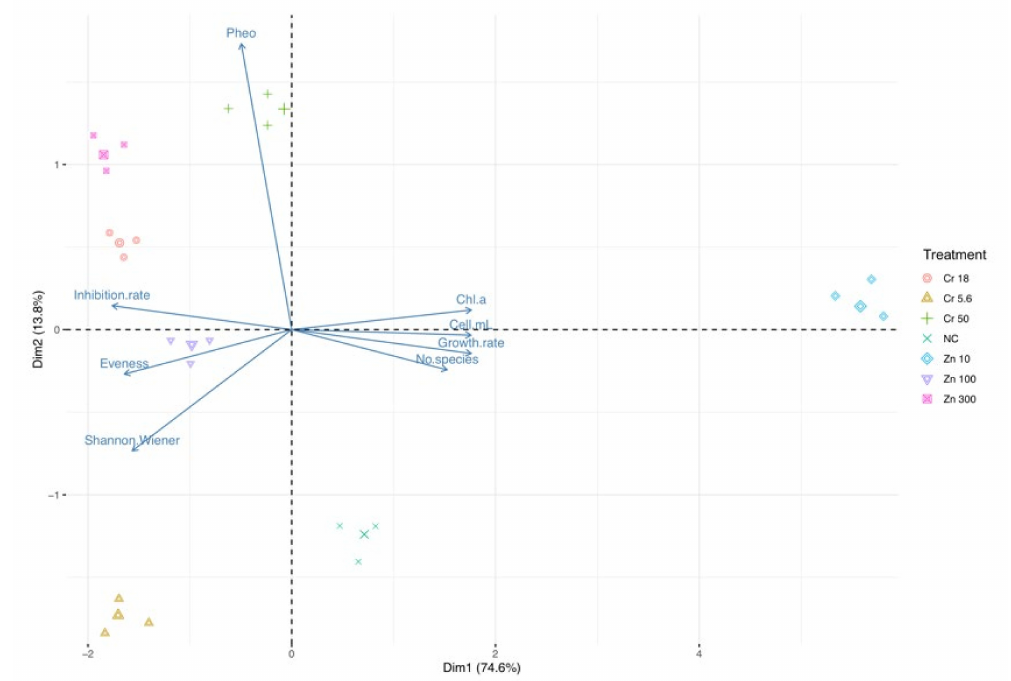
Figure 3. Principal component analysis. Trend in ecotoxicological indexes (pheophytin-Pheo, chlorophyll- a -Chl- a , inhibition rate, evenness, Shannon–Wiener, inhibition rate, growth rate, num- ber of species, cell density-cell/mL) across treatments (zinc oxide nanoparticles-Zn and potassium dichromate-Cr) in freshwater phytoplankton community (largest symbol = average